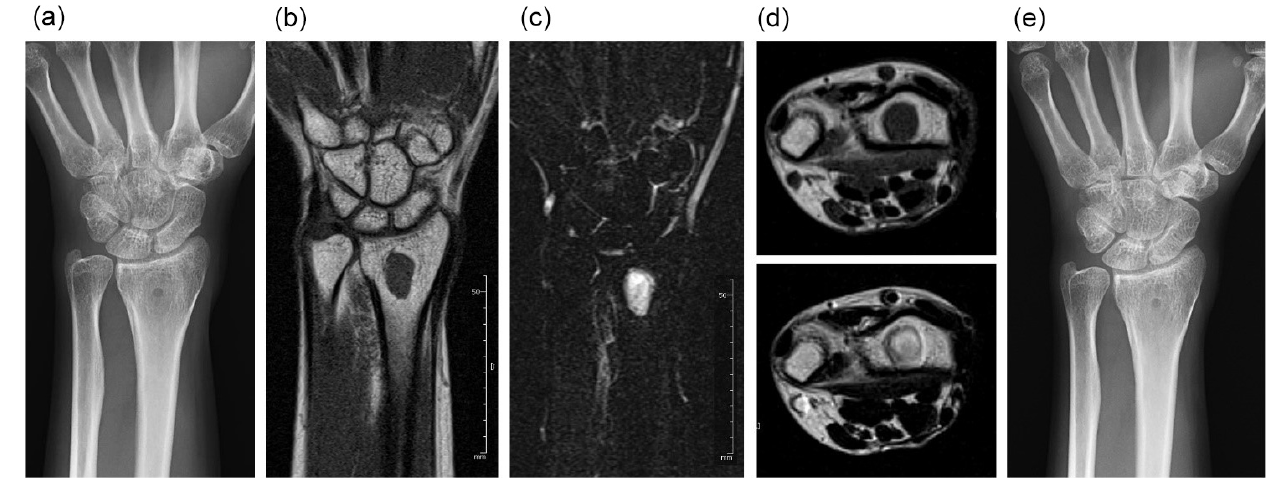
Figure 2. One year after treatment, the previously osteolytic area is ossified (a) . The lesion has homogenous, low signal intensity on T1- weighted imaging (b) and homogenous, high signal intensity on T2-weighted, fat-suppressed imaging (c) . No fluid collection is present ( d – top image, T1-weighted imaging; d – bottom image, T2-weighted imaging). Two years after treatment, no recurrence is seen (e)